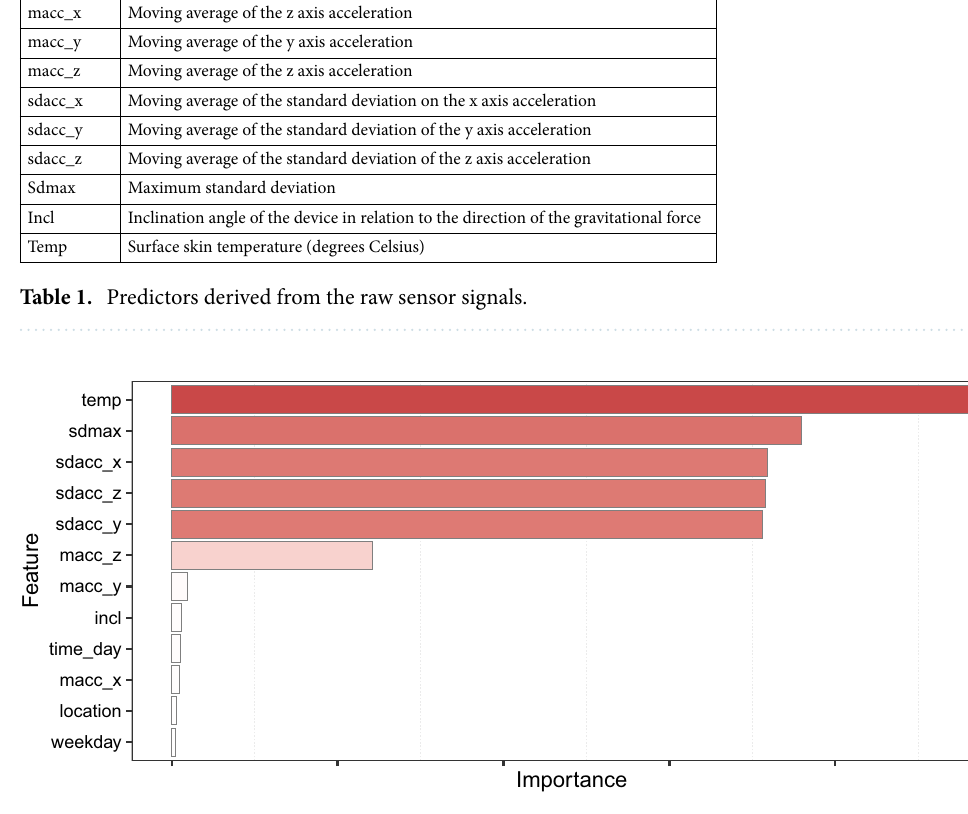
Figure 2. Predictor permutation importance plot for the decision tree including all predictors. The six most important predictors were used for training a second decision tree ( tree_imp6 ), while all predictors excluding temperature were used to train a third decision tree ( tree_no_temp